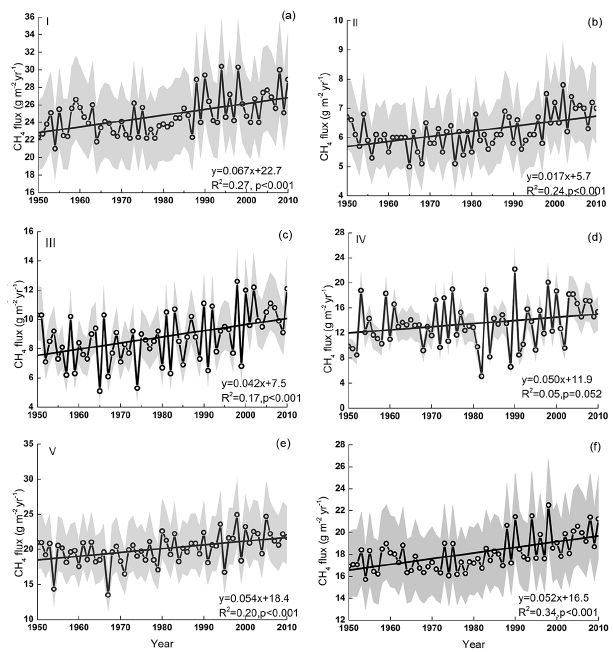
Figure 4. Methane fluxes from inland and coastal wetlands between 1950 and 2010 in (a) Region I, (b) Region II, (c) Region III, (d) Re- gion IV, (e) Region V, and (f) all of